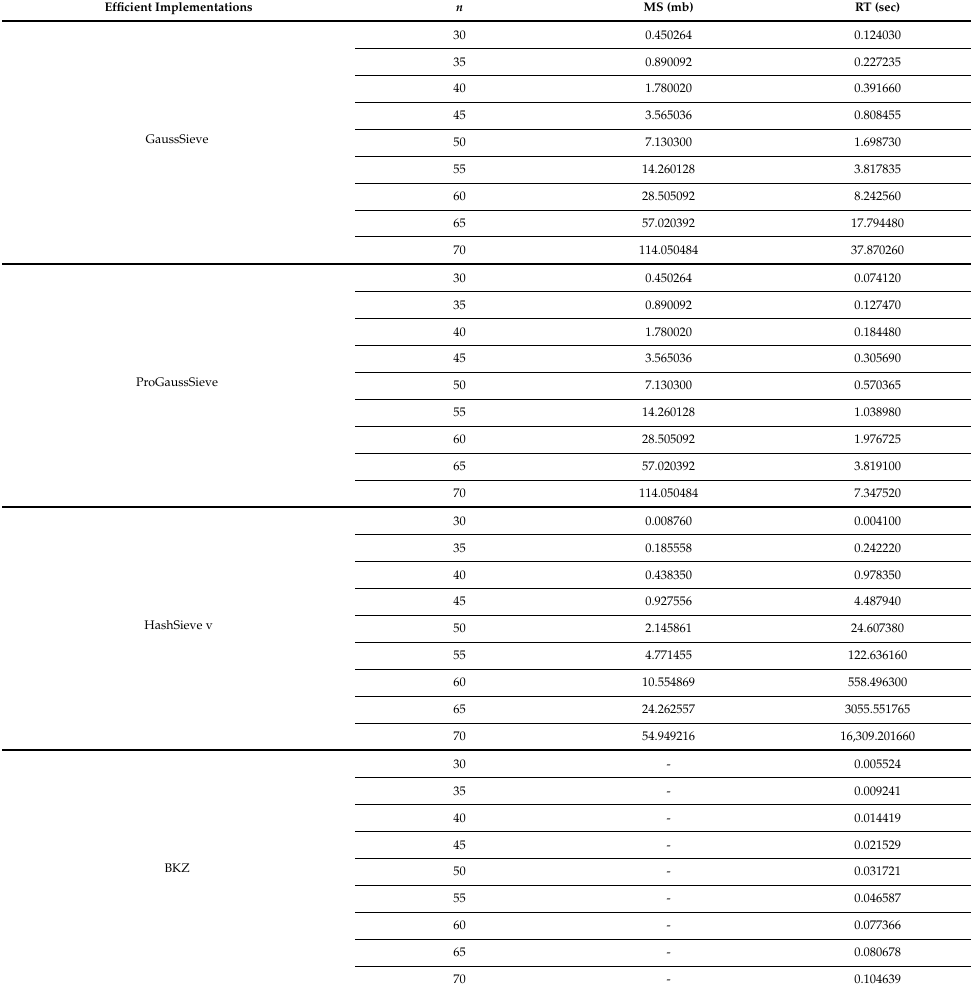
Table 2. The comparison of the run times of the efficient implementations ( n : lattice size, MS: memory space, and RT: run